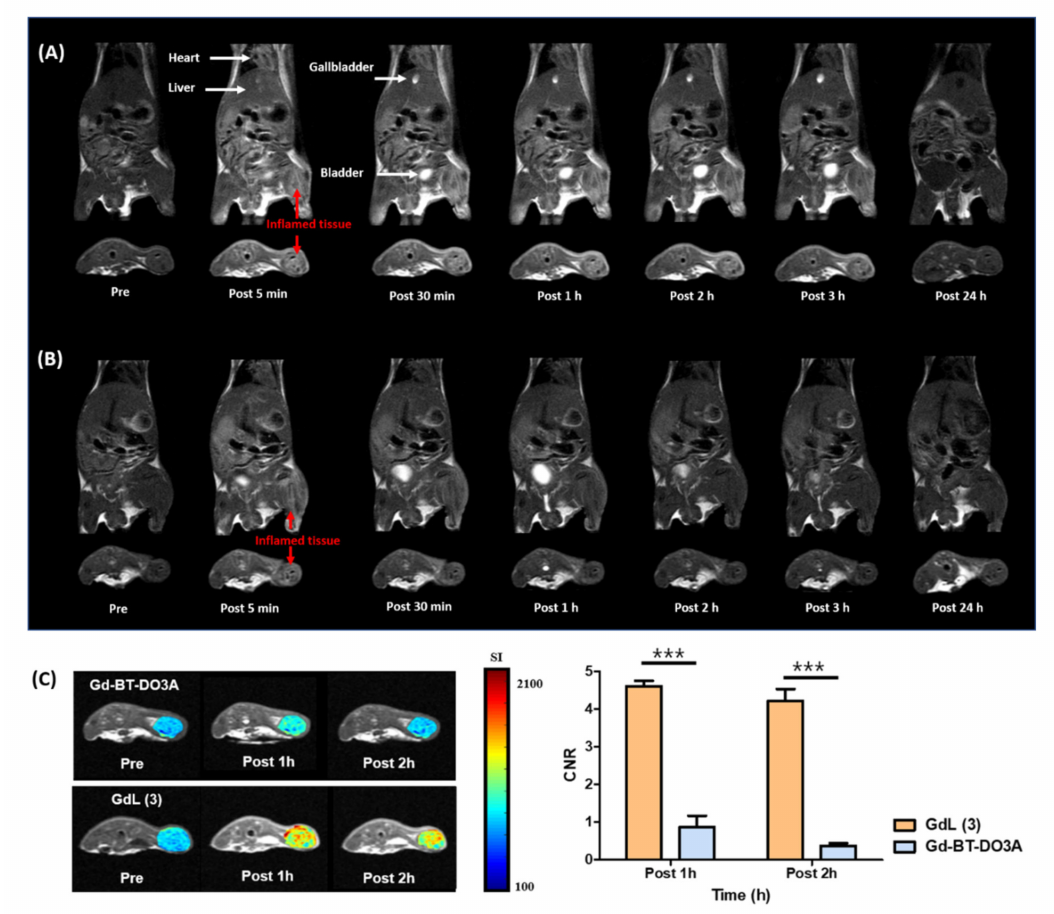
Figure 3. Inflammation targeting of gadolinium and rosmarinic acid (GdL (3)). ( A , B ) T 1 -weighted MR images of inflammation-induced ICR mice obtained after the intravenous injection of GdL (3) and Gd-BT-DO3A, respectively (0.1 mmol (Gd) / kg, n = 3 for each group). ( C ) Contrast-to-noise ratio (CNR) profiles and in vivo MR axial images of mice bearing inflamed thigh tissues obtained after the injection of GdL (3) and Gd-BT-DO3A. CNR was calculated using Equation (2). *** p <